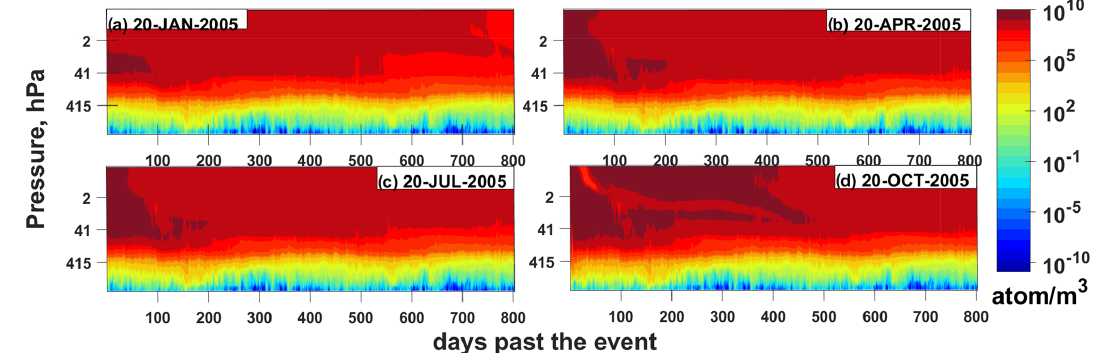
Figure 9. Polar (at 85 ◦ N latitude) mean concentration of 10 Be in the Northern Hemisphere for SPEs occurring in different seasons.